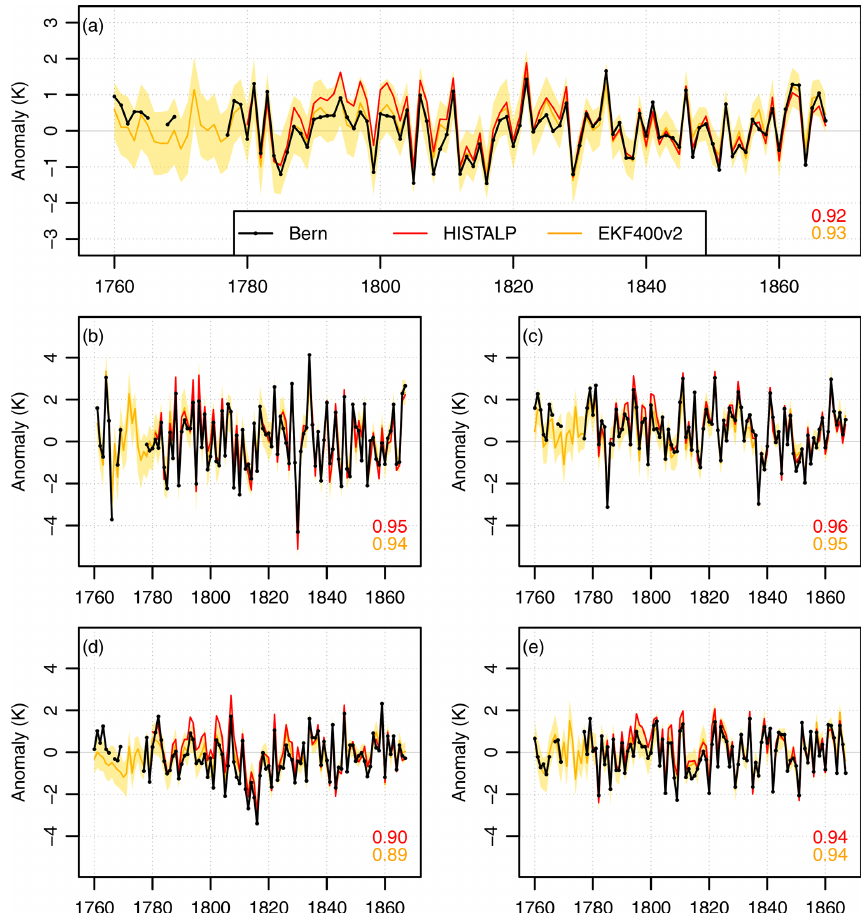
Figure 11. (a) Annual temperature series for Bern and for the nearest grid point of the HISTALP and EKF400 data sets, expressed as anomalies with respect to the period 1801–1850. The shading represents the ensemble spread in EKF400. The same is also shown for (b) December–February, (c) March–April, (d) June–August, and (e) September–November. Pearson correlation coefficients between Bern and the other data sets are also